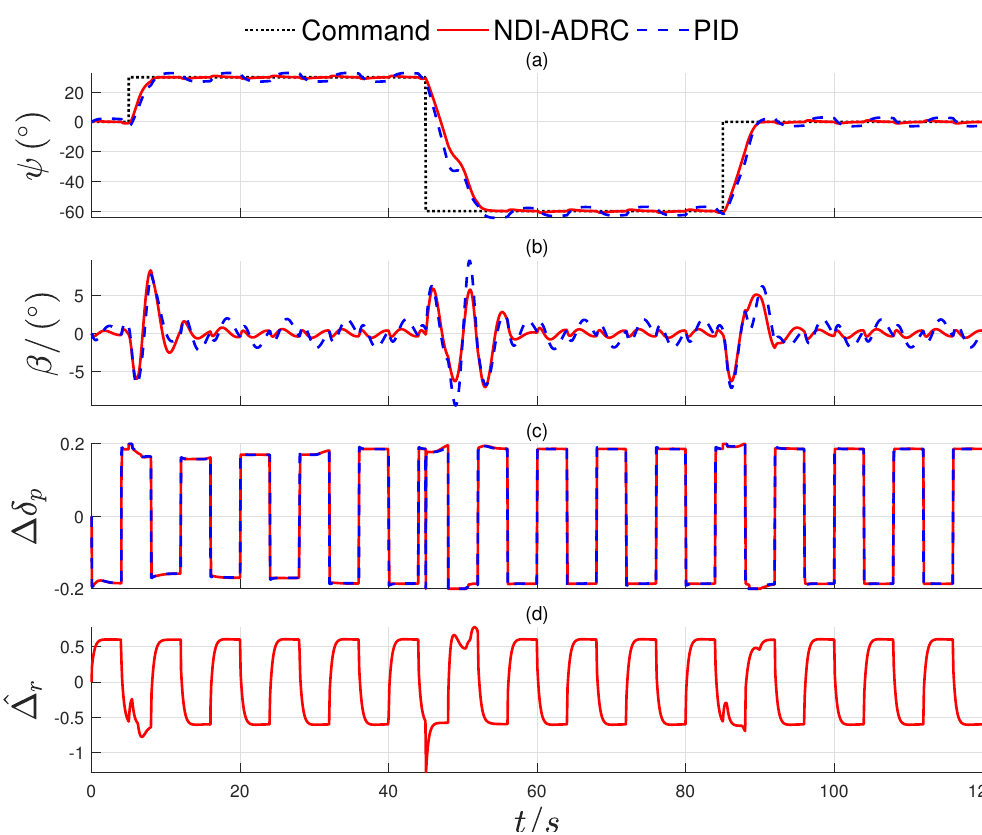
Figure 10. The yaw angle ( a ), side-slip angle ( b ), differential propeller thrust ( c ) and observer ( d ) curves of NDI-ADRC and PID controllers for the disturbed yaw